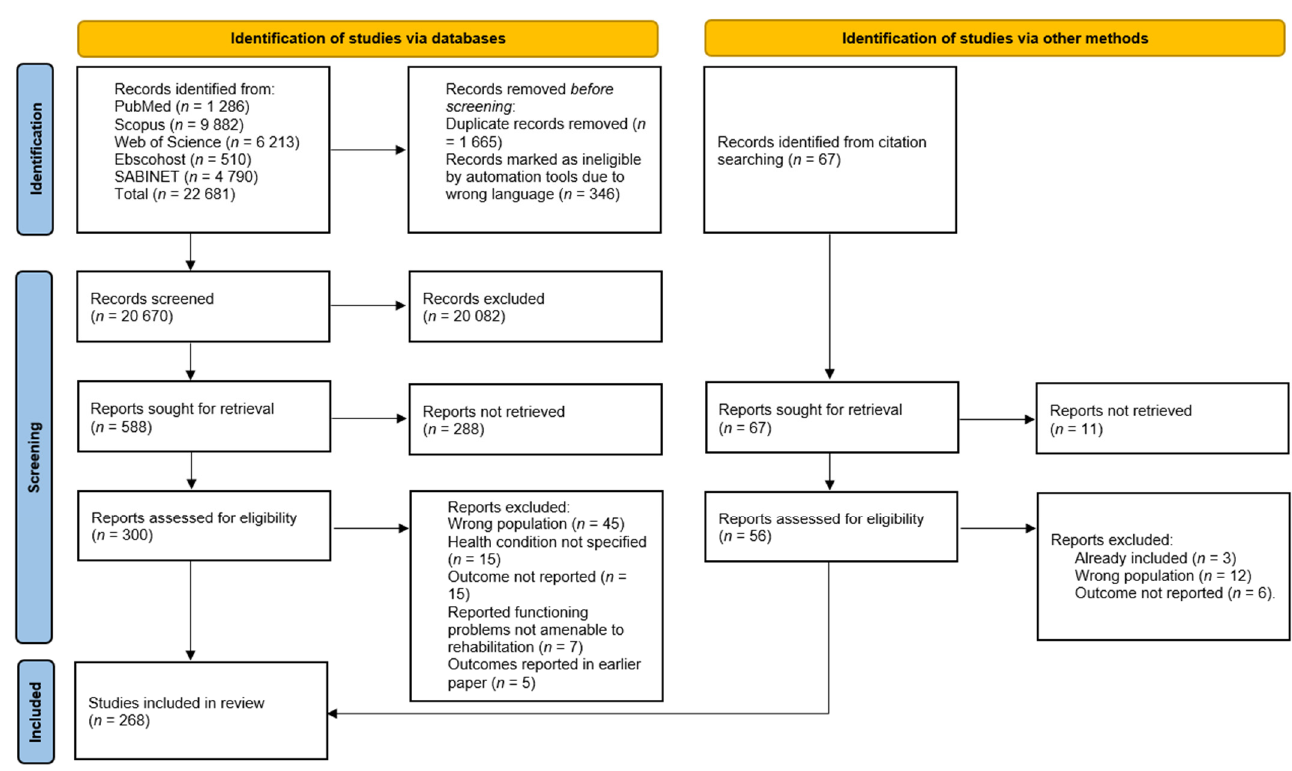
Figure 1. PRISMA flow diagram.